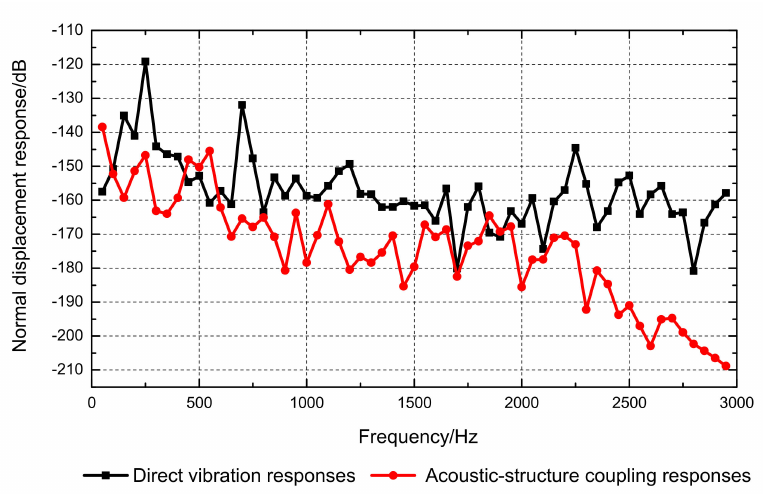
Figure 5. Vibration responses of the shell: ( a ) in vacuum; ( b ) in water.